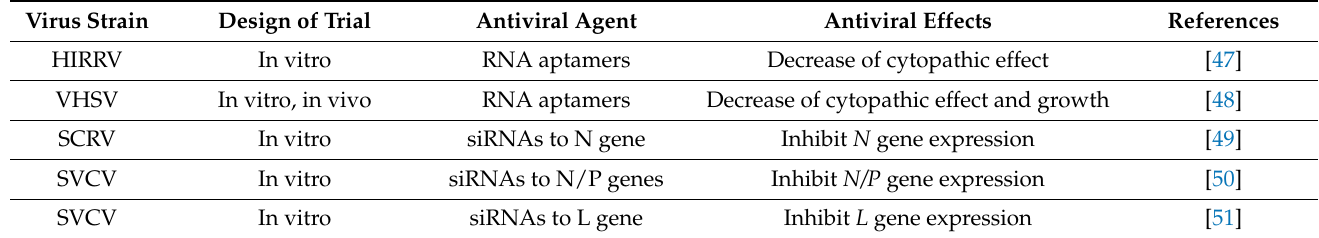
Table 3. Antiviral nucleic acids against fish rhabdoviruses and their antiviral effects. Virus